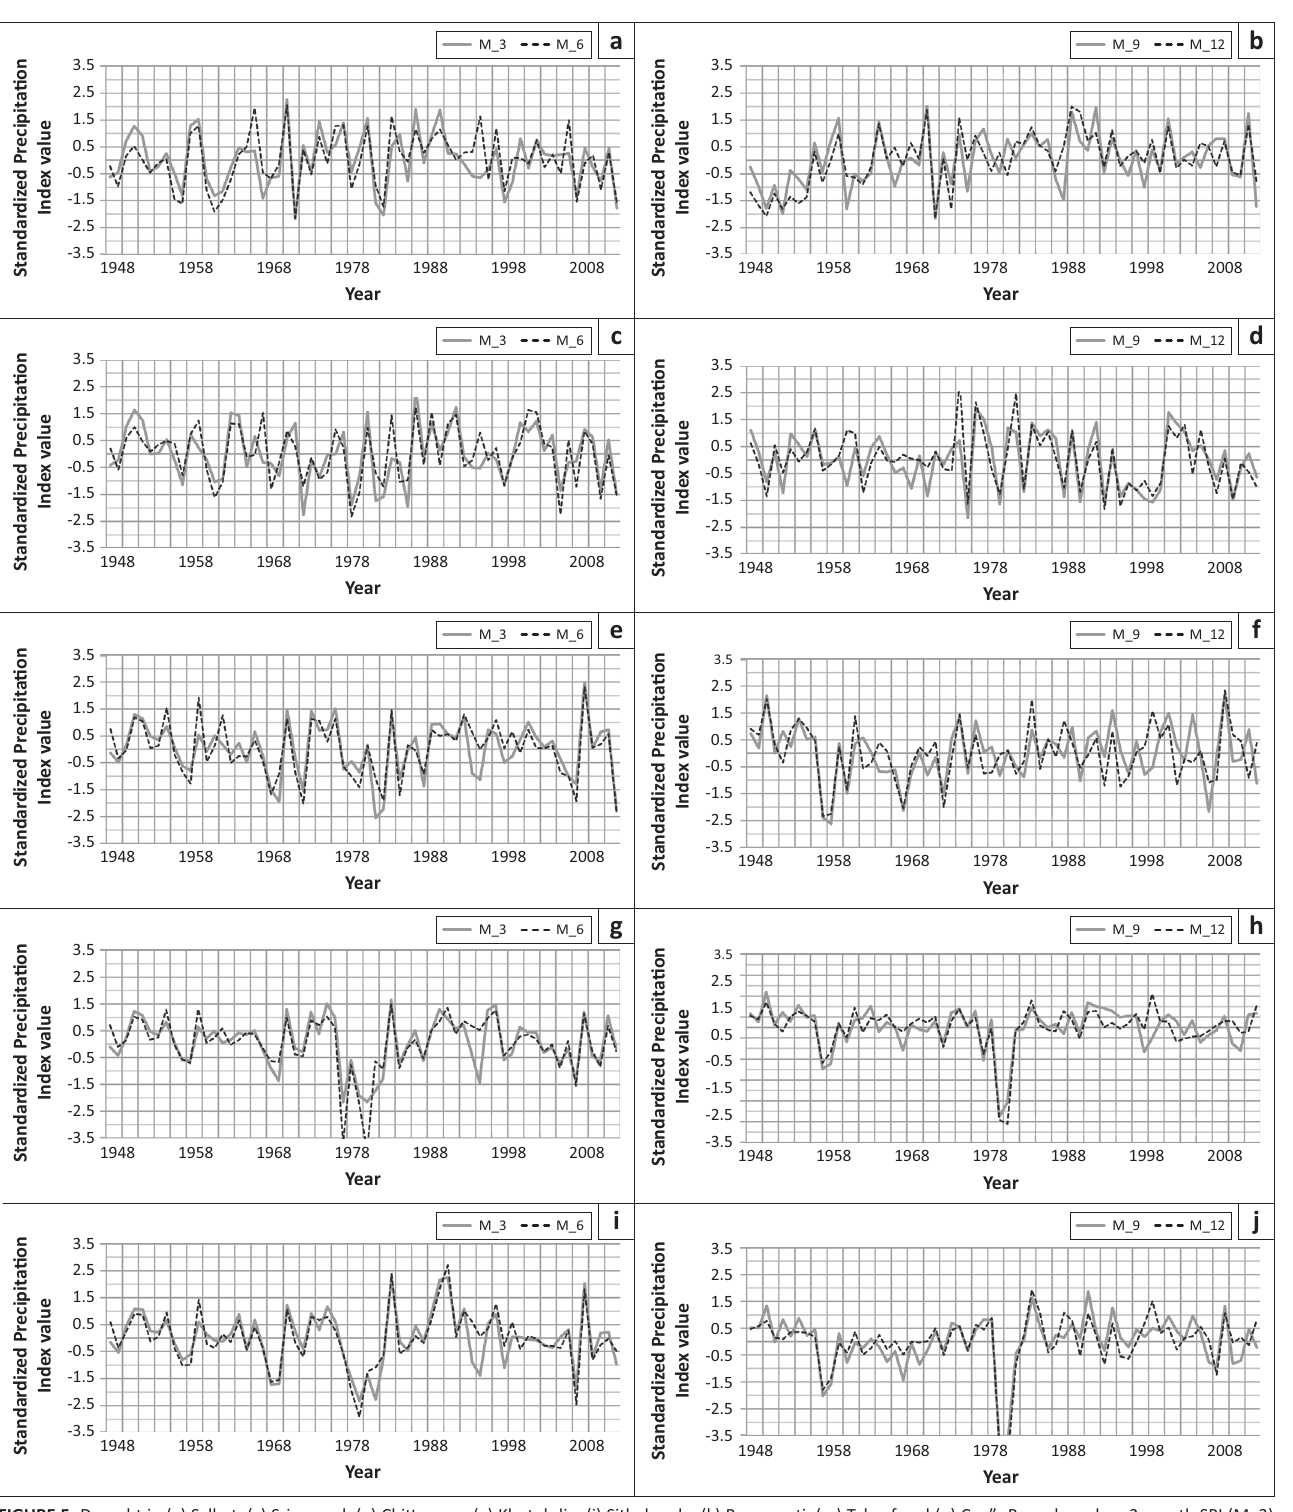
FIGURE 5: Drought in (a) Sylhet, (c) Srimangal, (e) Chittagong, (g) Khutubdia, (i) Sithakunda, (k) Rangamati, (m) Teknaf and (o) Cox”s Bazar based on 3-month SPI (M_3) and 6-month SPI (M_6). Drought in (b) Sylhet, (d) Srimangal, (f) Chittagong, (h) Khutubdia, (j) Sithakunda, (l) Rangamati, (n) Teknaf and (p) Cox”s Bazar based on 9-month SPI (M_9) and 12-month (annual) SPI (M_12).